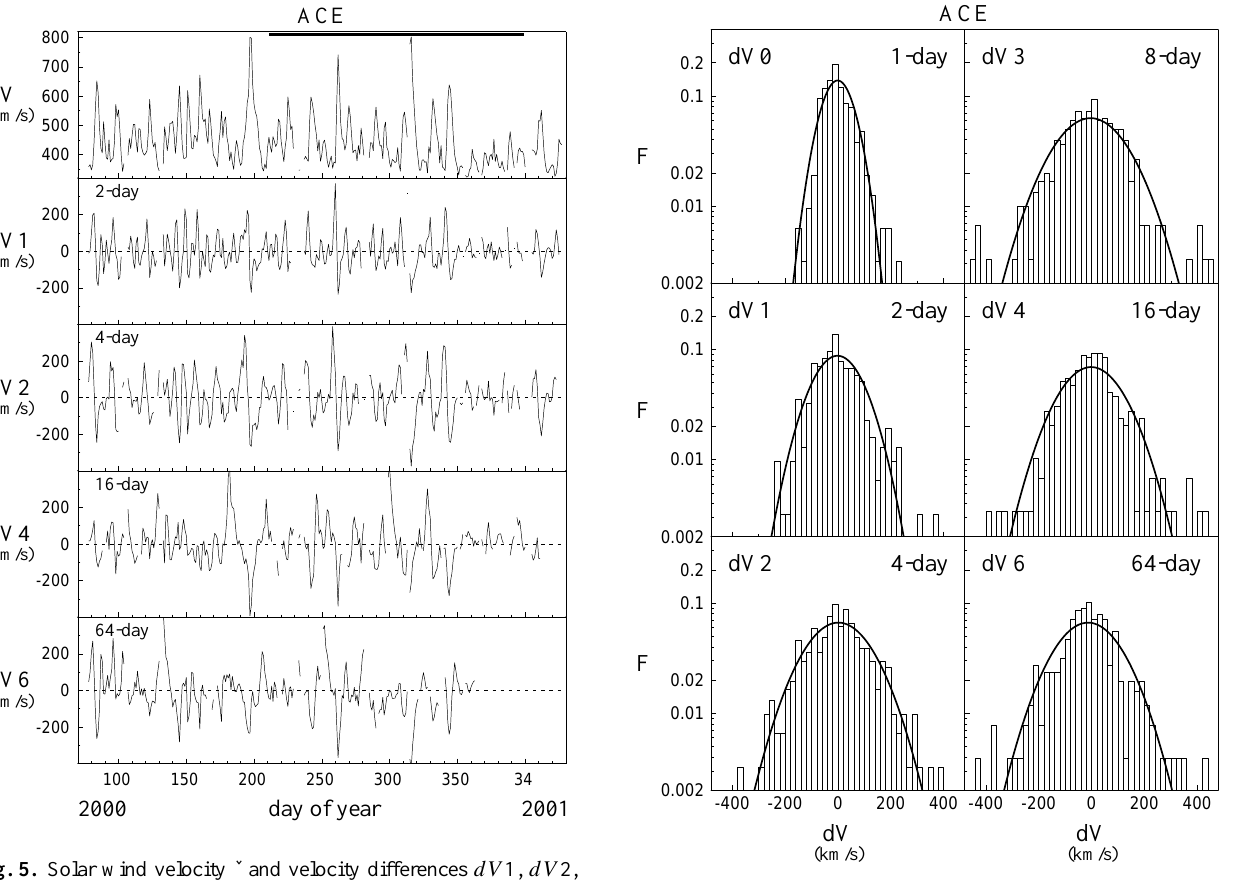
Fig. 6. Frequency histograms for the ACE velocity differences, in the same format of Fig.